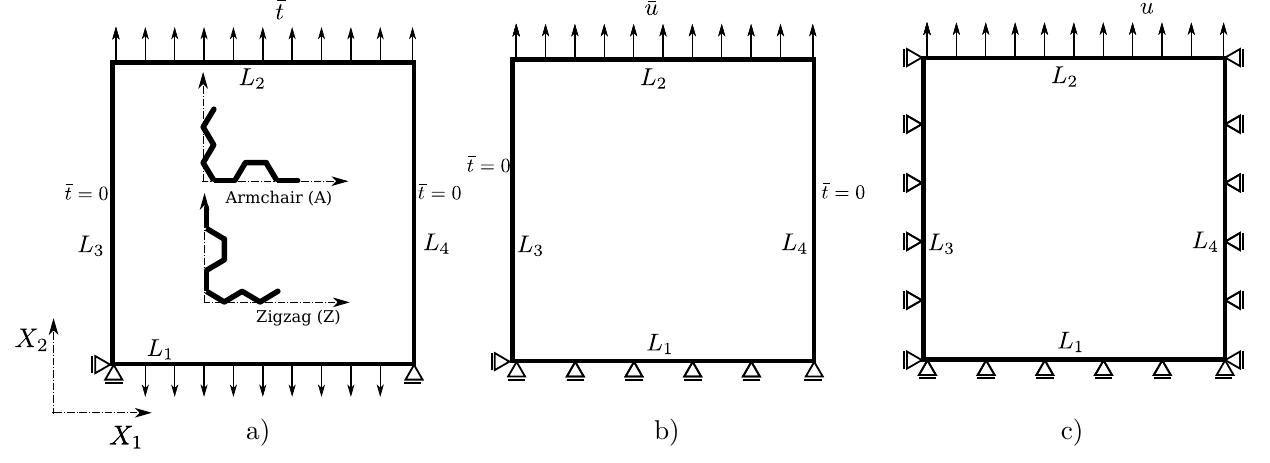
Figure 2. Scheme of the lattice sample with the traction (Reuss) ( a ), mixed ( b ) and displacement (Voigt) boundary conditions (BC) ( c ). The envelope of the sample is composed of lines L – L , which coincides with boundary 1 4